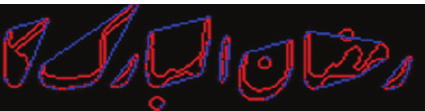
Figure 8: Computation of convex hull on Urdu script (blue: convex